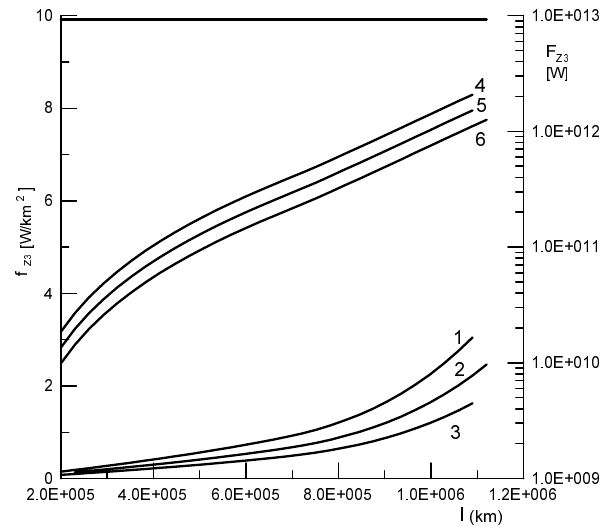
Fig. 4. Dependence of the total “geoeffective” energy flux den- sity of the magnetosonic waves penetrating into the magnetosphere (curves 1–3 and the vertical axis f z 3 at the left) on the magneto- spheric tail length – l . The numbered curves correspond to the tran- sition layer thickness: 1 – 1 = 0; 2 – 1 = 10 4 km; 3 – 1 = 2 × 10 4 km. The energy density level of the waves incident on the transition layer f z 3 ’ 9 . 8 W/km 2 is shown at the top. Curves 4–6 (and the vertical axis F z 3 at the right) represent the in- tegral (throughout the entire lateral surface of the magnetosphere) “geoeffective” wave energy flux for the same values of the thickness 1 as in plots 1–3 (correspondence 4 ←→ 1, 5 ←→ 2, 6 ←→